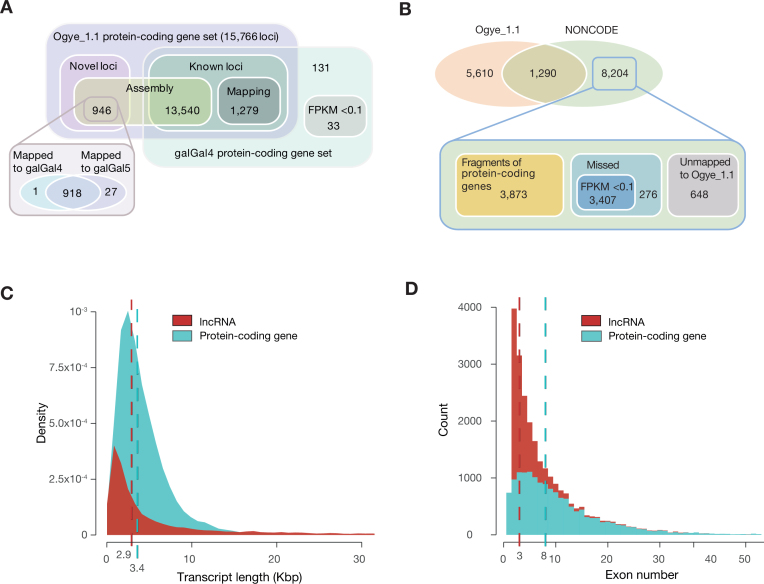

(A) A Venn diagram showing the number of protein-coding genes in the Ogye_1.1 genome. (B) A Venn diagram showing the number of Ogye_1.1 and galGal4 lncRNAs. (C) Distribution of transcript length (red for lncRNAs and cyan for protein-coding genes). The vertical dotted lines indicate the median length. (D) Distribution of the number of exons per transcript. Otherwise, as in (C).